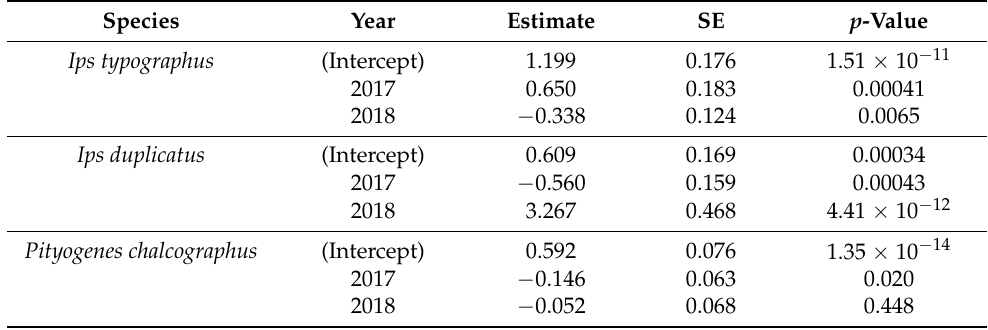
Table A2. Relationships between number of maternal galleries and year, type of plot (distance from lure tree), and tree height of position of strip on trap tree as indicated by the general linear model 1/(number of maternal galleries) = 1 + year + type + height. The coefficient estimates are accompanied with the standard error of estimate (SE) and the p